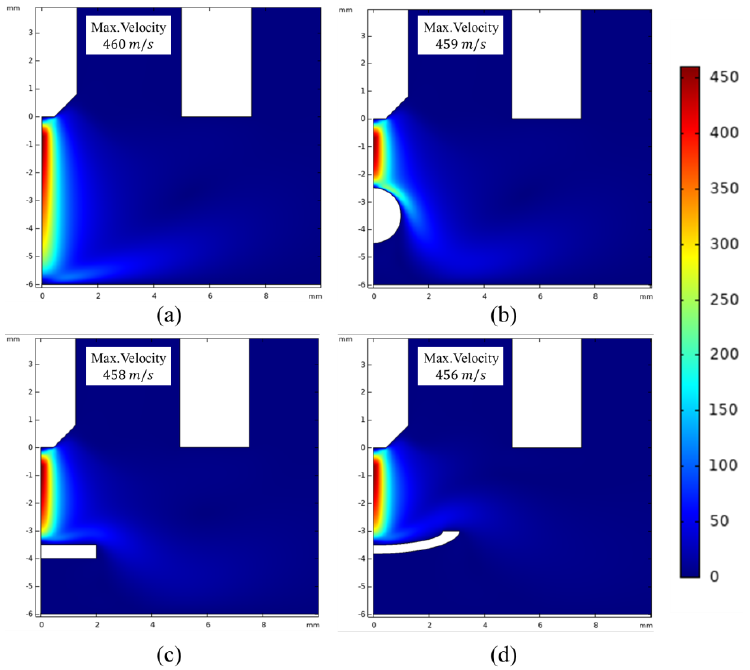
Figure 10. Velocity distribution of arc plasma according to obstruction structure shape: ( a ) None type; ( b ) Sphere shape; ( c ) Cylinder shape; ( d ) Concave shape.